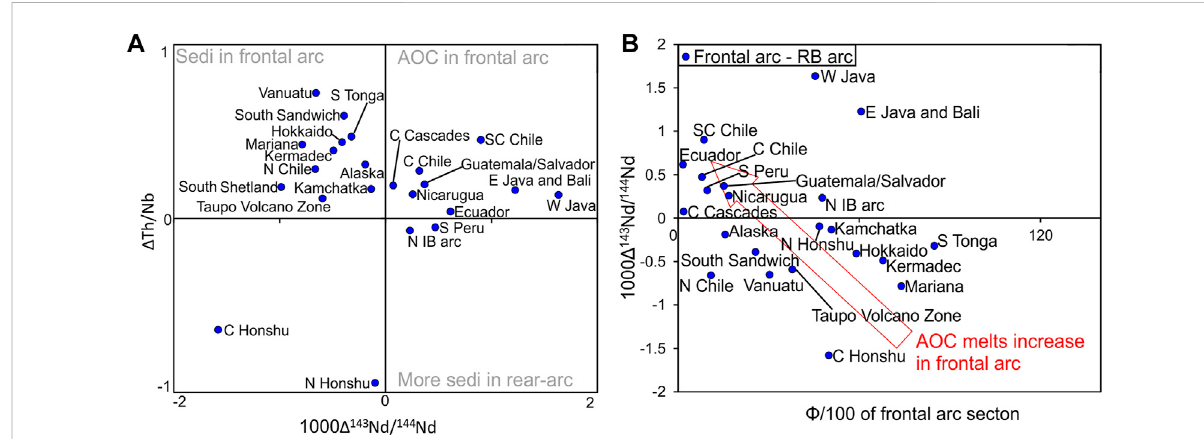
FIGURE 6 Comparison of 143 Nd/ 144 Nd and Th/Nb between the frontal arc and rear-/back-arc sections. (A) 1000 Δ 143 Nd/ 144 Nd vs. Δ Th/Nb. Negative 1000 Δ 143 Nd/ 144 Nd (frontal arc minus rear-/back-arc) with positive Δ Th/Nb indicates more sediment melts in the frontal arc than the rear-/back-arc whilepositive Δ Ɛ Nd withpositive Δ Th/NbindicatesmoreAOCmeltsinthefrontalarc. (B) Φ /100vs.1000 Δ 143 Nd/ 144 Nd.Positive1000 Δ 143 Nd/ 144 Ndare found in subduction zones with small Φ /100 indicating AOC can melt in hot subduction zones. The high-potassium rocks in the Java rear-arc are considered to form by partial melting of an enriched mantle (Edwards et al., 1991; Edwards et al., 1994) which shows an anomaly in